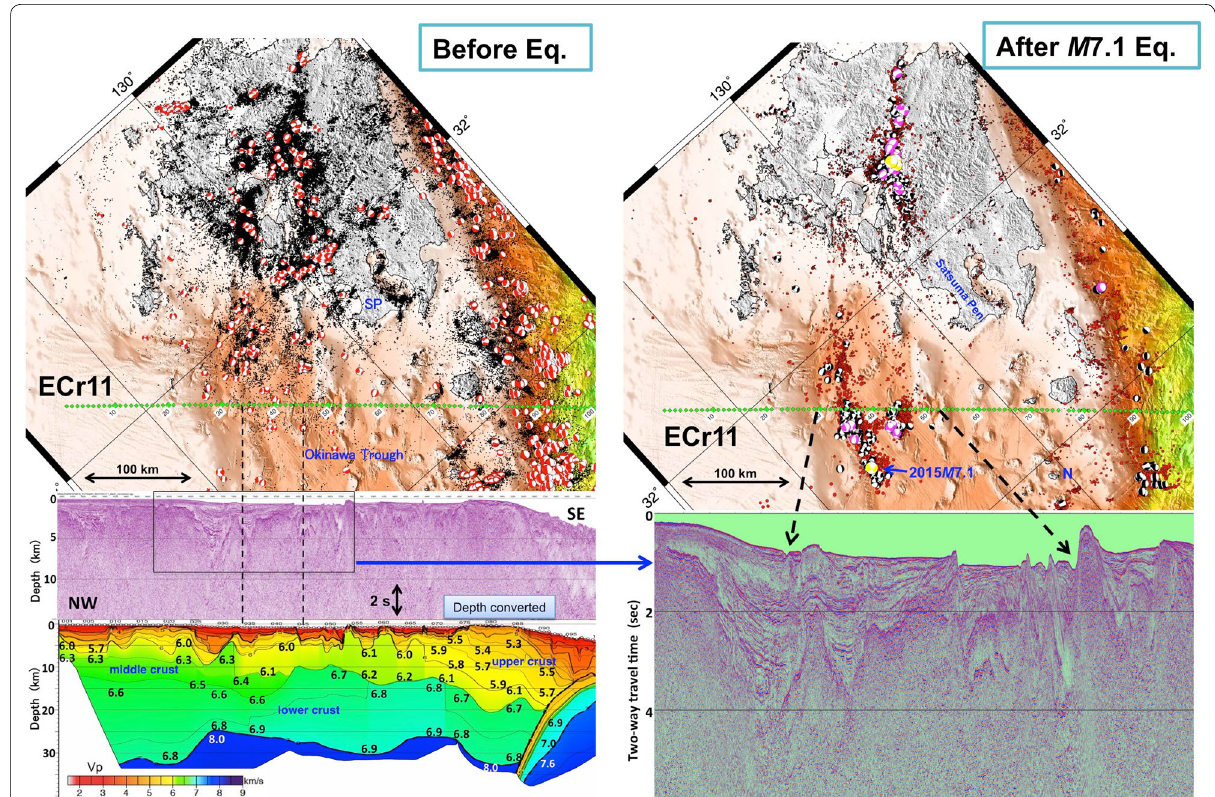
Fig. 16 (Top left) Epicenter distribution before the Satsuma-hanto Seiho-oki Earthquake ( M 7.1) on November 14, 2015. Black dots show epicenters with depths shallower than 30 km as determined by the Japan Metrological Agency (1923–2015, November 14). Focal mechanisms are from the F-net CMT Catalog by the National Research Institute for Earth Science and Disaster Resilience (depth 30 km, 1997–2015, November 14). The ≤ locations of the OBSs on ECr11 in the northernmost OT are indicated by green squares. The MCS profile (depth-converted section) and V p model along ECr11 are shown on the center and bottom left. The V p of the middle crust between two broken lines is slightly slower than both sides. (Top right) Epicenter distribution of the M 7.1 earthquake and their aftershocks (depth 30 km, 2015, November 14–2017, May 2). CMT mechanisms, ≤ yellow, M 6; pink, M 5. A tsunami with a height of 30 cm caused by the M 7.1 earthquake was observed at Nakanoshima island shown by N in the ≥ ≥ map. The MCS time section across the aftershock area is enlarged on the bottom